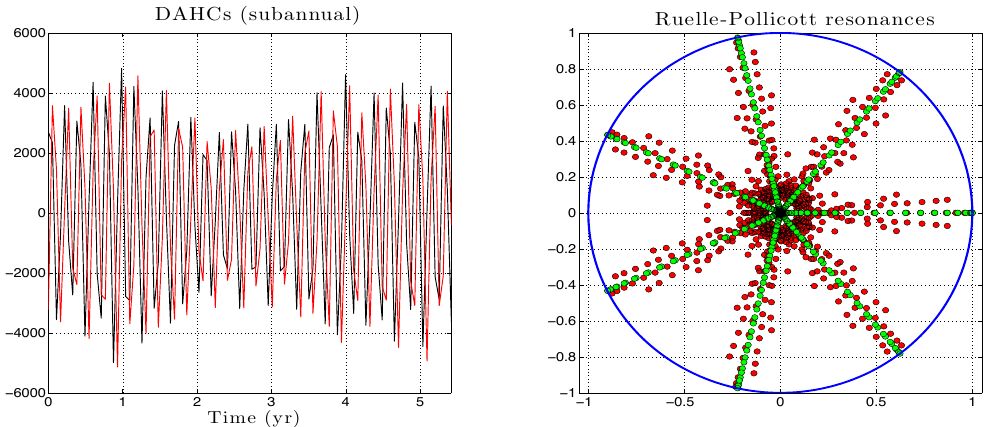
Figure A4. Reduced RP resonances and their analytic approximation. Same as in Figure A2, but for the frequency f = 5.27 cycle/ y − 1